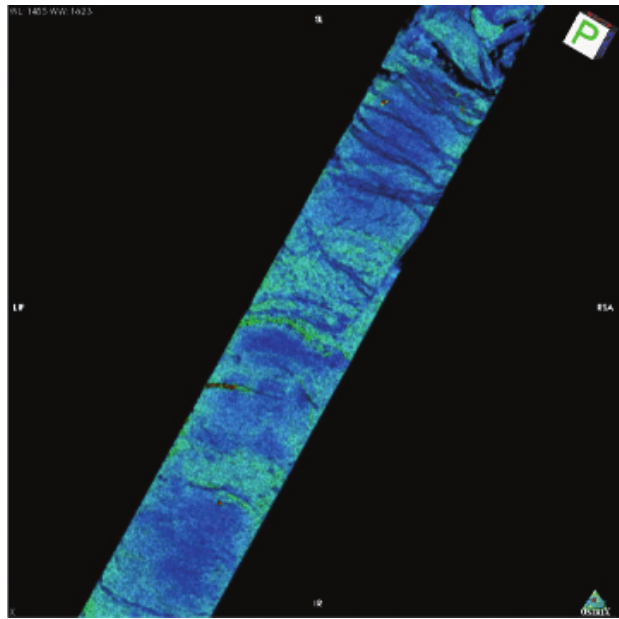
Figure 1. The OsiriX-rendered false colored image of a core section based on XCT scanning data. Fractures and gaps are easily visualized in this image. Change in color from light blue to red can be interpreted to be a reflection of change in density of core material, although calibration is a must to conclude about